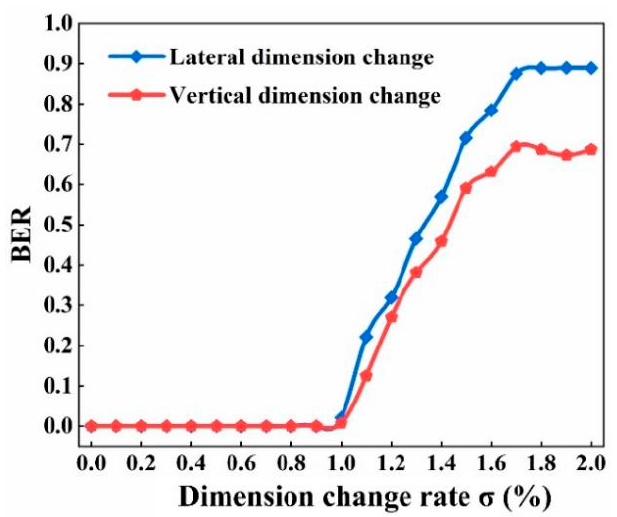
Figure 4. Without any compensation, the BER of the reconstructed signal pattern for different lateral dimension change rates σ L and vertical dimension change rates σ V . ( σ = σ L, σ = σ V